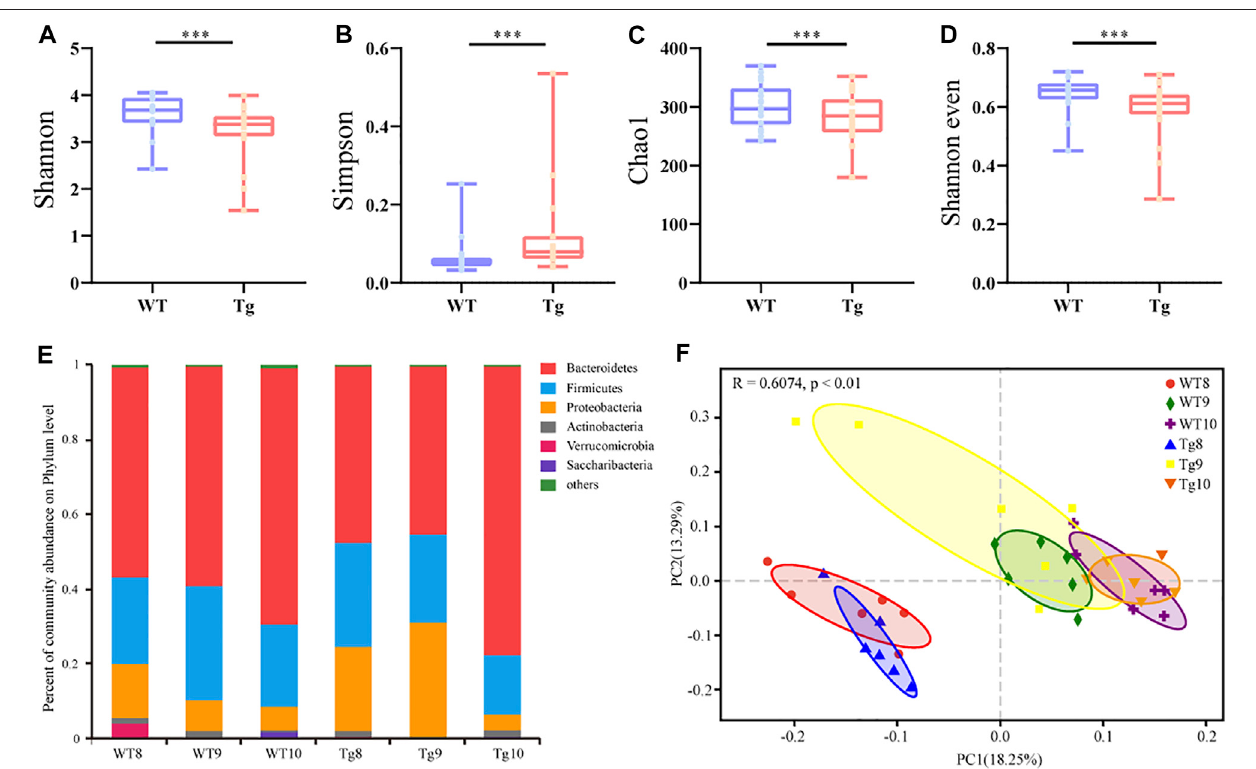
FIGURE 4 | Alteration of gut microbiota pro fi le in AD model (A – D) α diversity of WT ( n (cid:1) 6) and Tg mice ( n (cid:1) 6) evaluated by Shannon (A) , Simpson (B) , Chao1 (C) , and Shannon even indices (D) . Error bars represent mean ± S.E.M. * p < 0.05 versus Tg; ** p < 0.01 versus Tg; ** p < 0.001 versus Tg, *** p < 0.0001 versus Tg, by Wilcoxonrank-sumtest. (E) Bacterialtaxonomicpro fi lingatphylumlevel.Numberinthegroupnamerepresentsmonthsofage. (F) Principalcomponentanalysis(PCoA) based on unweighted UniFrac